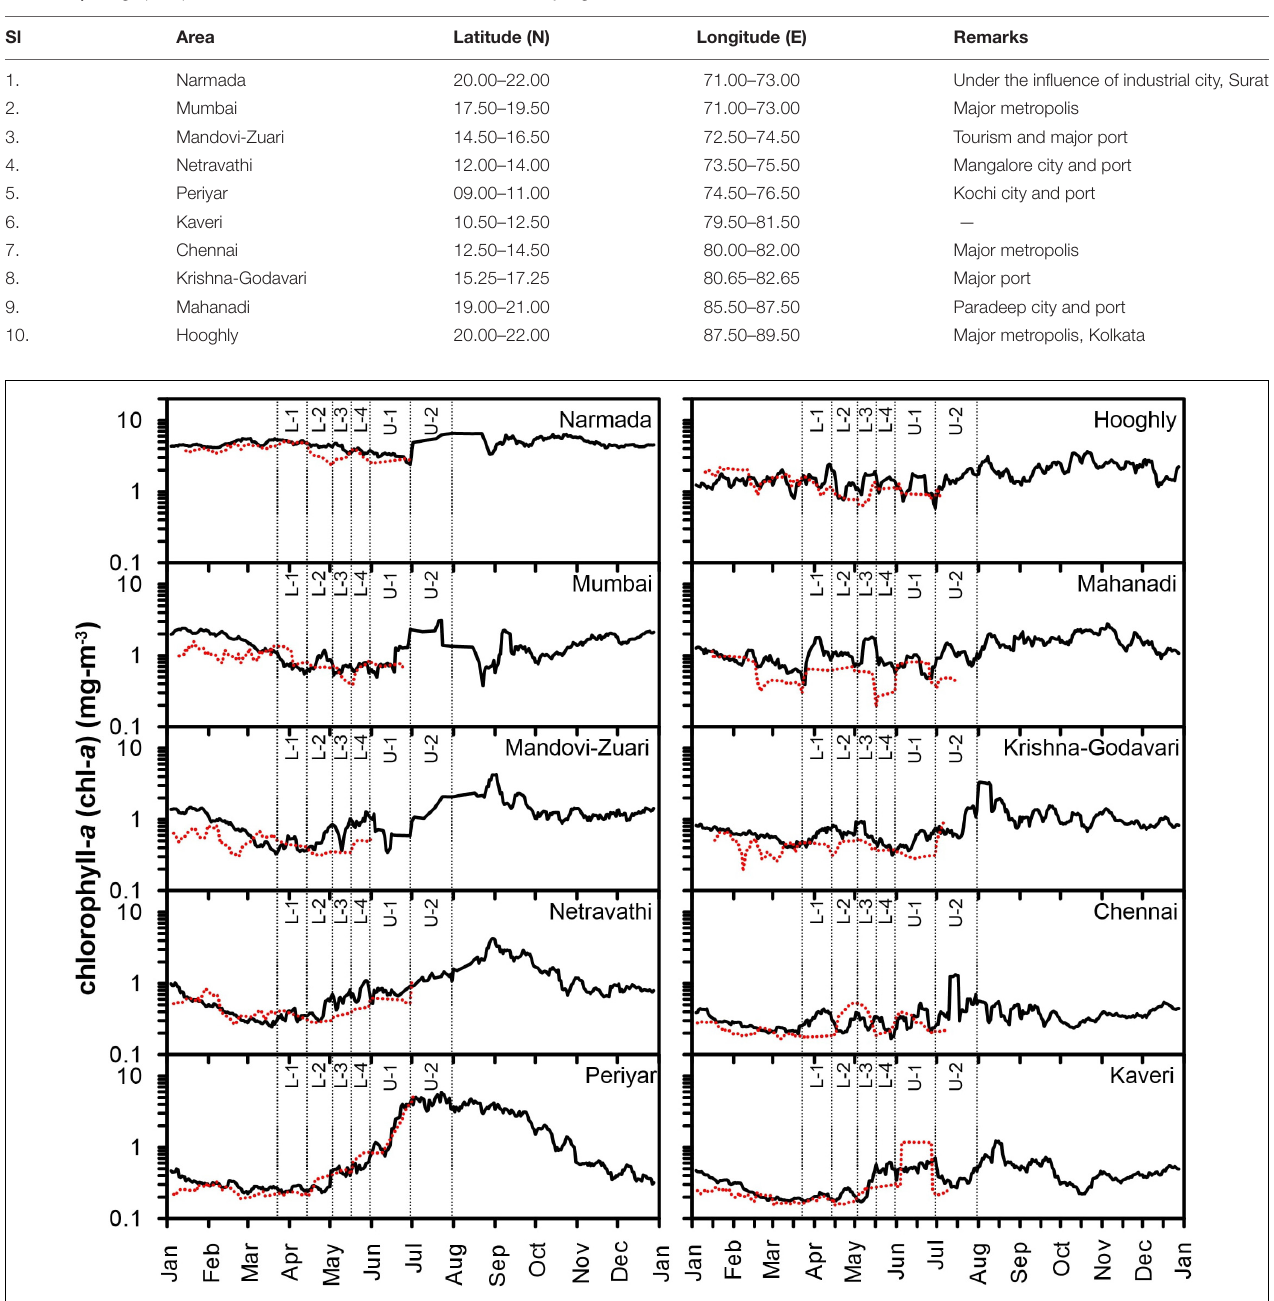
TABLE 1 | Geographic positions and environmental attributes of the study regions.